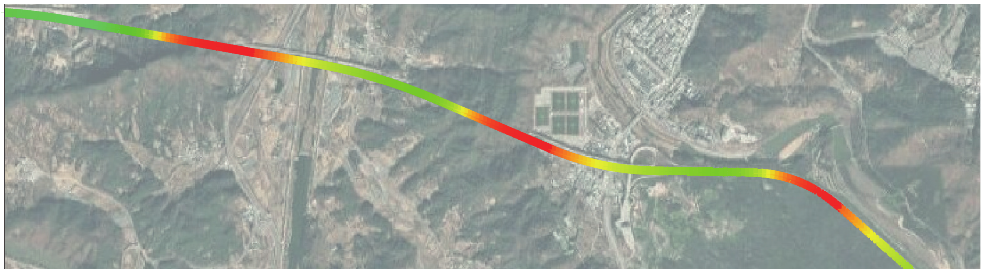
Figure 18. Scenario 4: GNSS signal outage in tunnels. Green denotes low dilution of precision, and red denotes high.